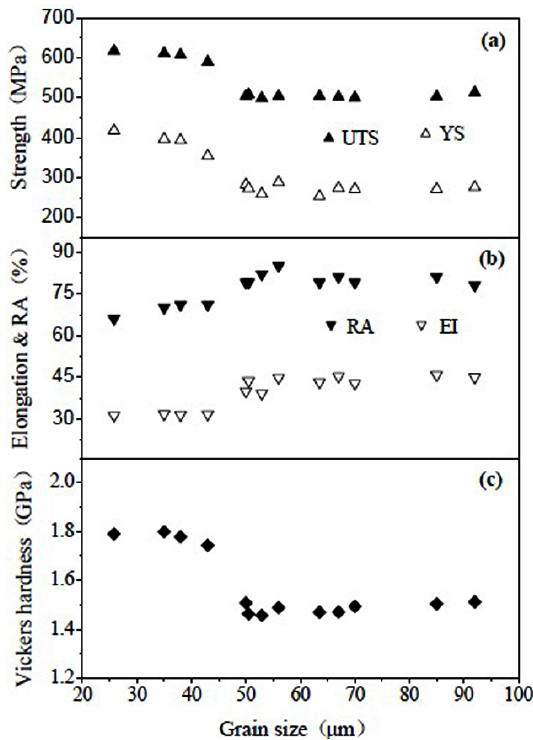
Figure 9. Effect of grain size on (a) yield strength and ultimate tensile strength; (b) on elongation and reduction in area; and (c) on vickers hardness of Ti-29Nb-13Ta-4.6Zr ([144], modified). Reprinted with permission from [144]. Copyright 2002 Springer